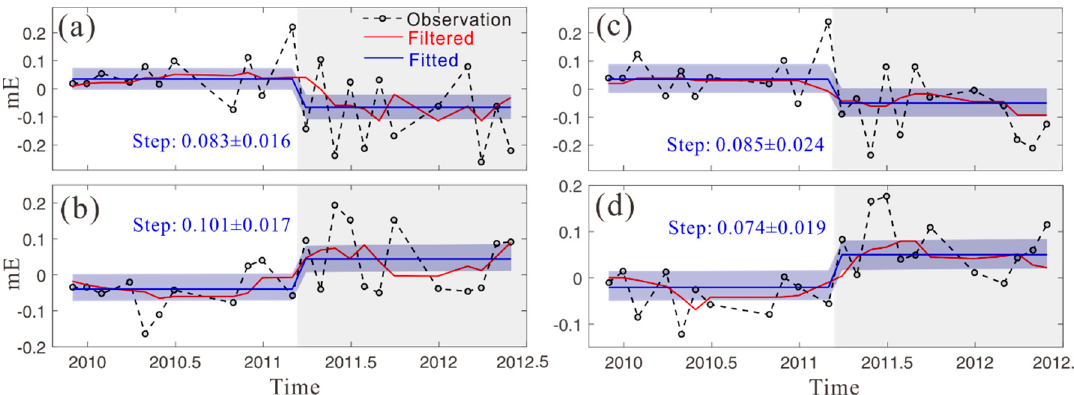
Figure 13. Radial gravity gradient changes at A ( a ), B ( b ) points and two selected areas around A and B ( c , d ) before and after earthquake. The red curves denote the filtered results after using a 1D median filter to the original time series, the blue curves are the fitted step functions. The double uncertainties are denoted by the blue areas.